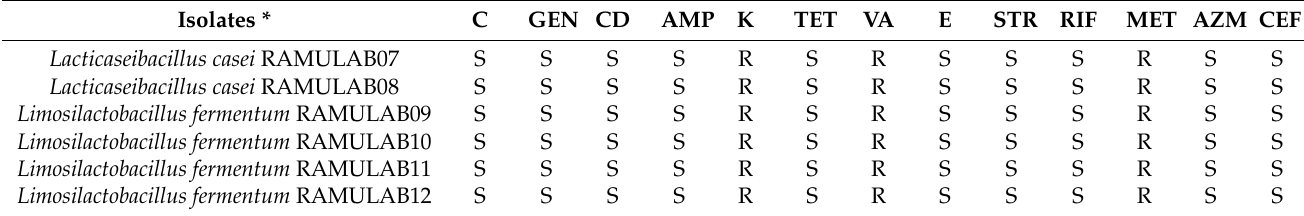
* “S” indicates sensitivity; “R” indicates